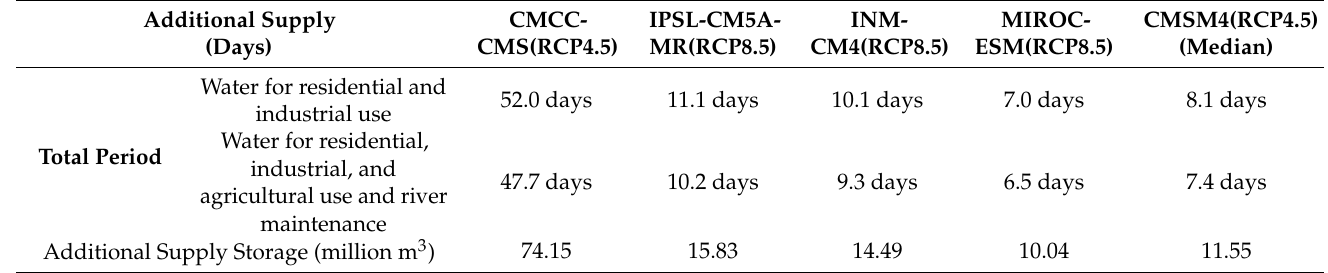
Table 6. Additional supply days and volume by climate change